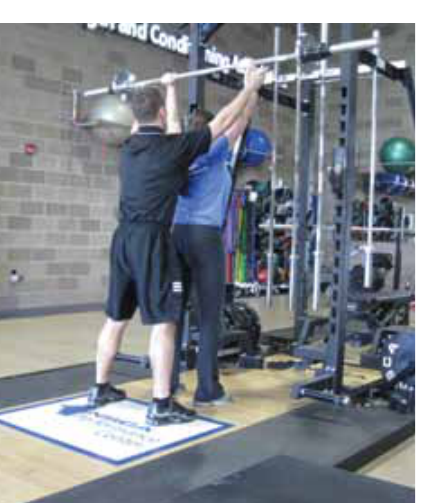
Figure 3-9. Spotter Assisting Ascent Figure 3-8. Bottom Lifting Position